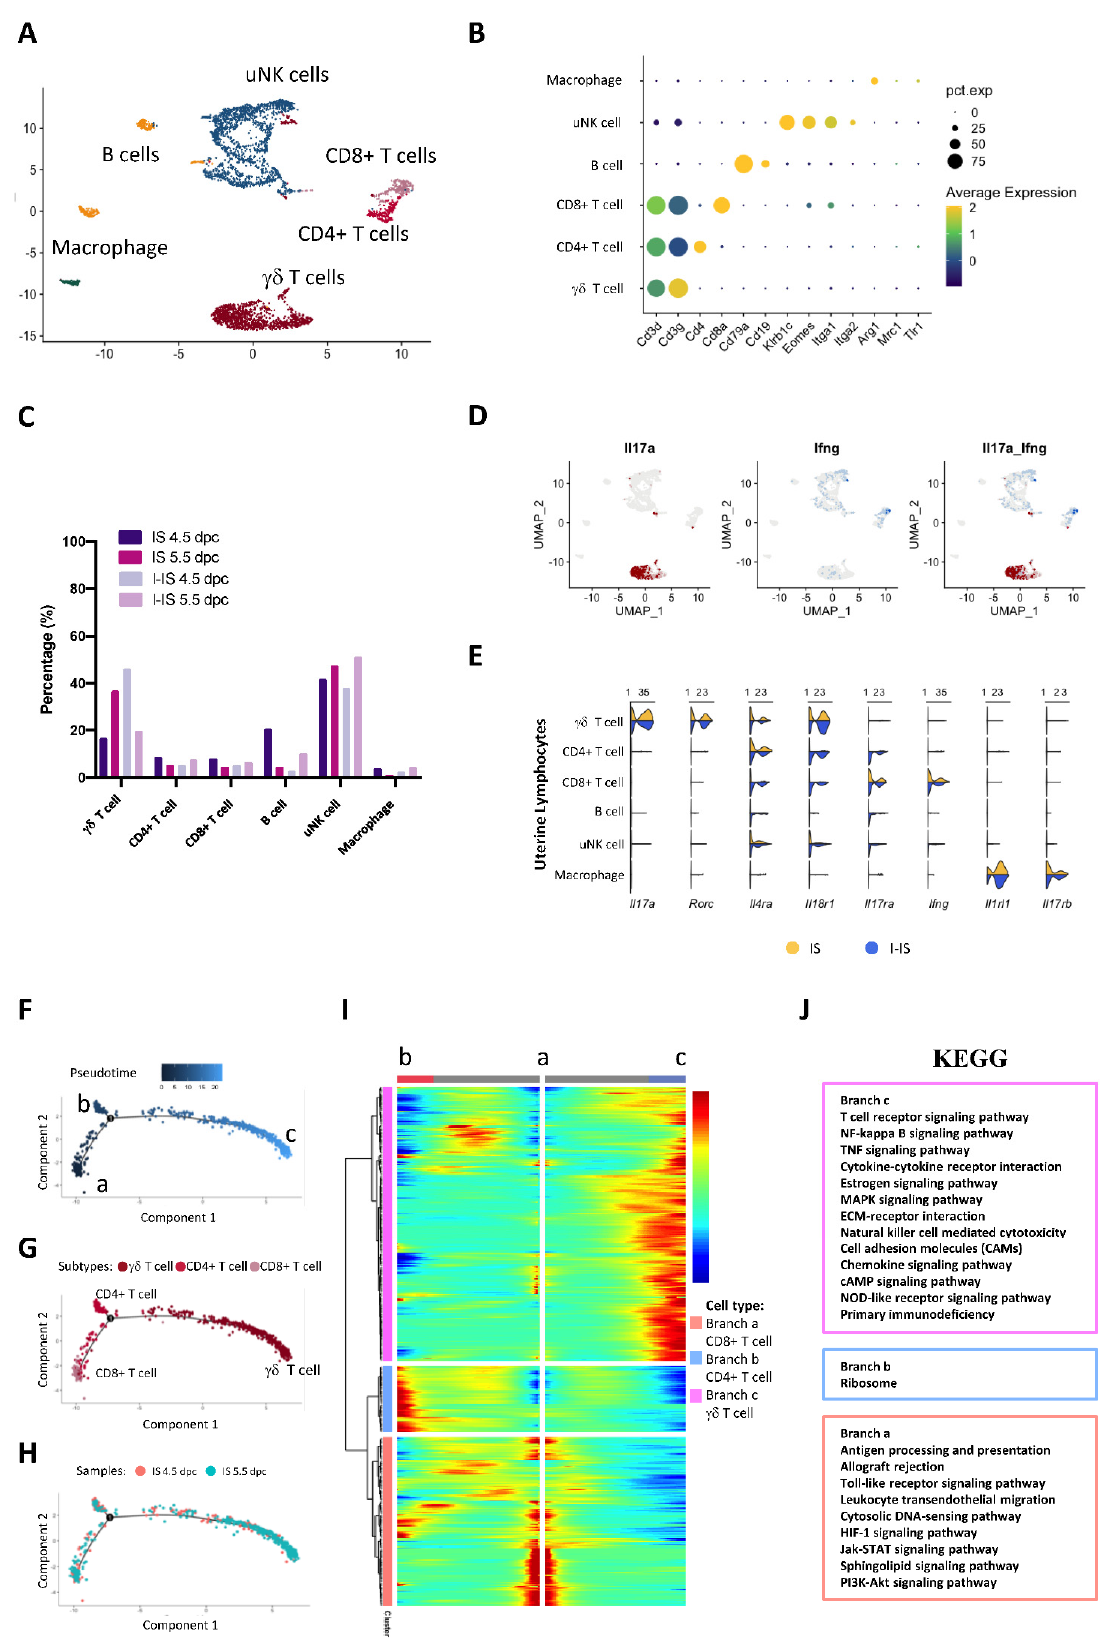
Figure 6. Lymphocyte populations and their functions in pregnant mice uteruses during